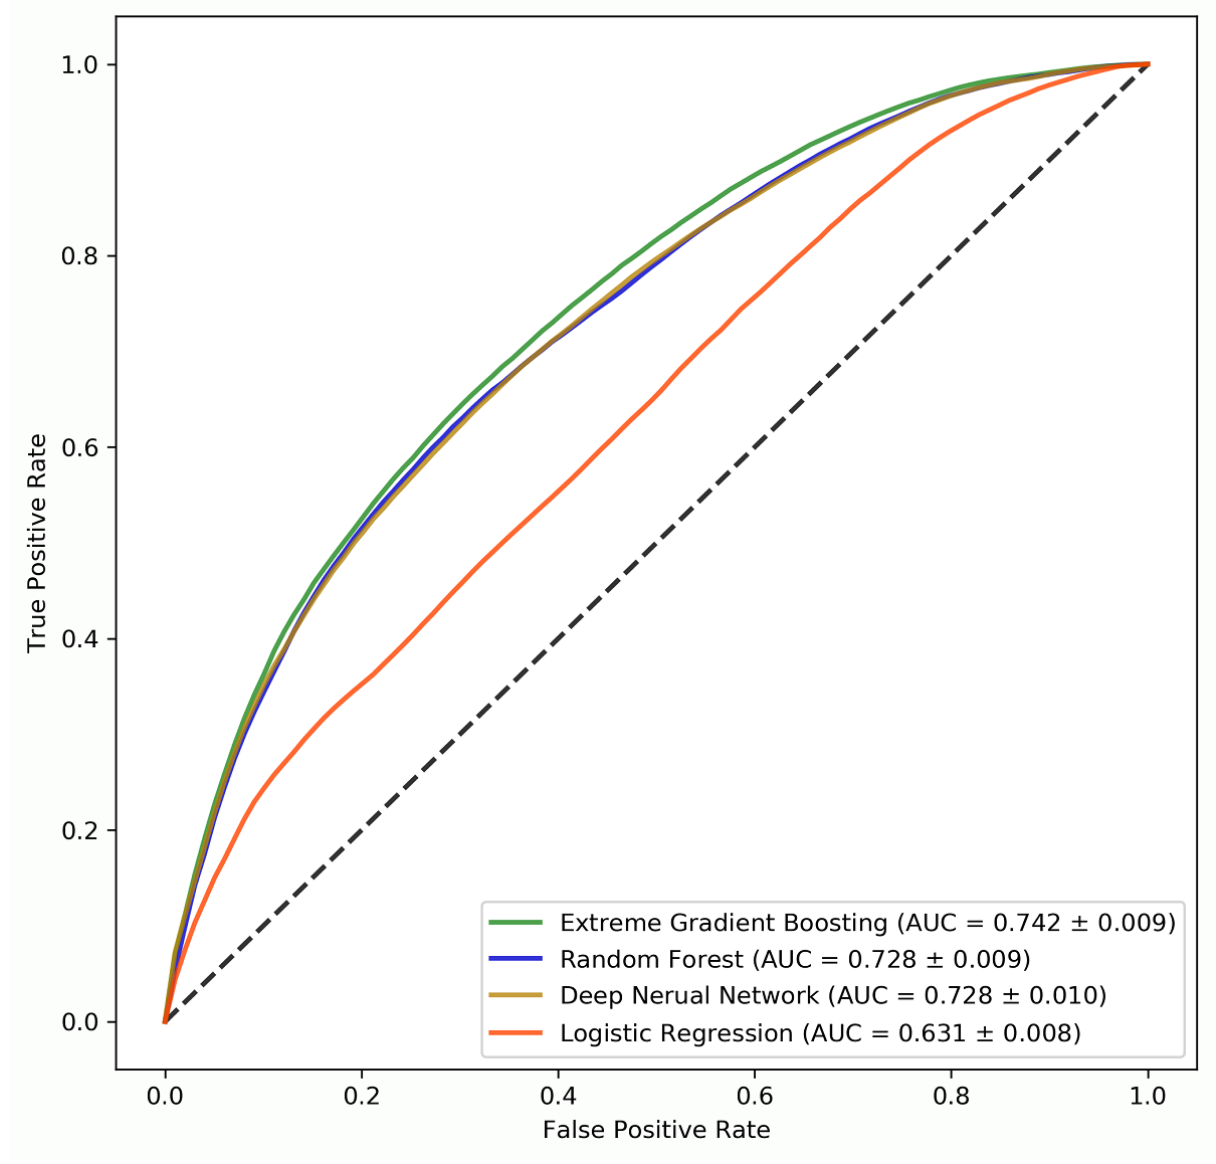
Figure 2. Mean receiver operating characteristic curves for the four machine learning algorithms.